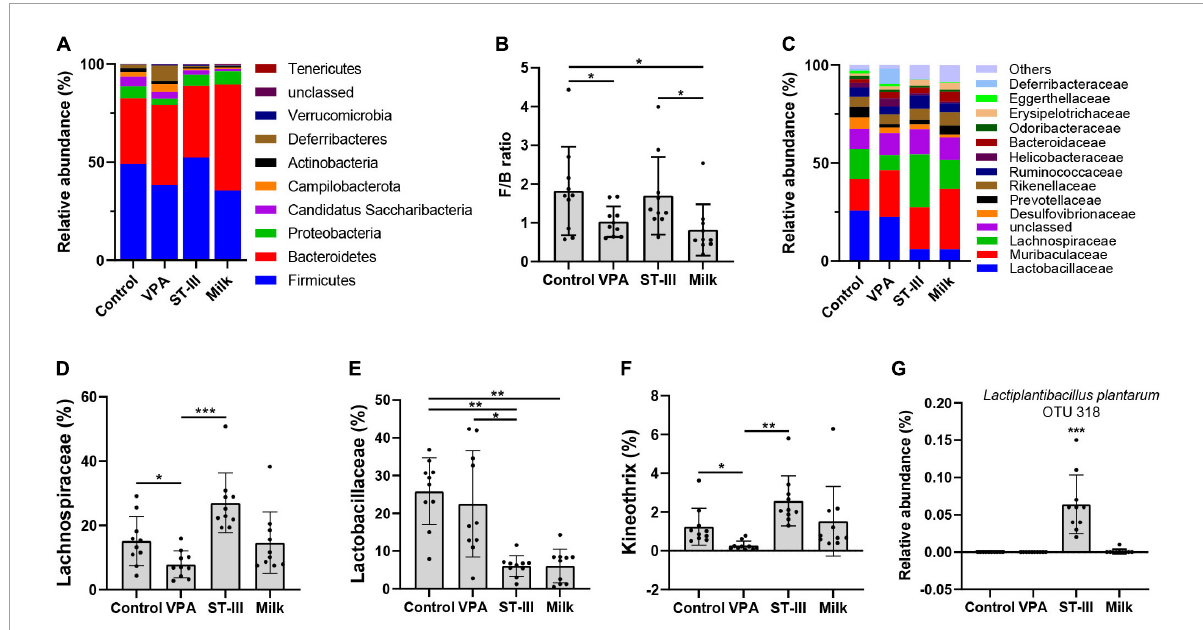
FIGURE3 The effect of milk and Lactiplantibacillus plantarum ST- III -fermented milk on gut microbial composition in male VPA mice. (A) Phylum level. (B) Firmicutes / Bacteroidetes (F/B) ratio. (C) Family level. Relative abundance of (D) Lachnospiraceae , (E) Lactobacillaceae , (F) Kineothrix , and (G) L. plantarum in control, VPA, ST-III and milk group. n = 10 per group. * p < 0.05, ** p < 0.01, *** p < 0.001.